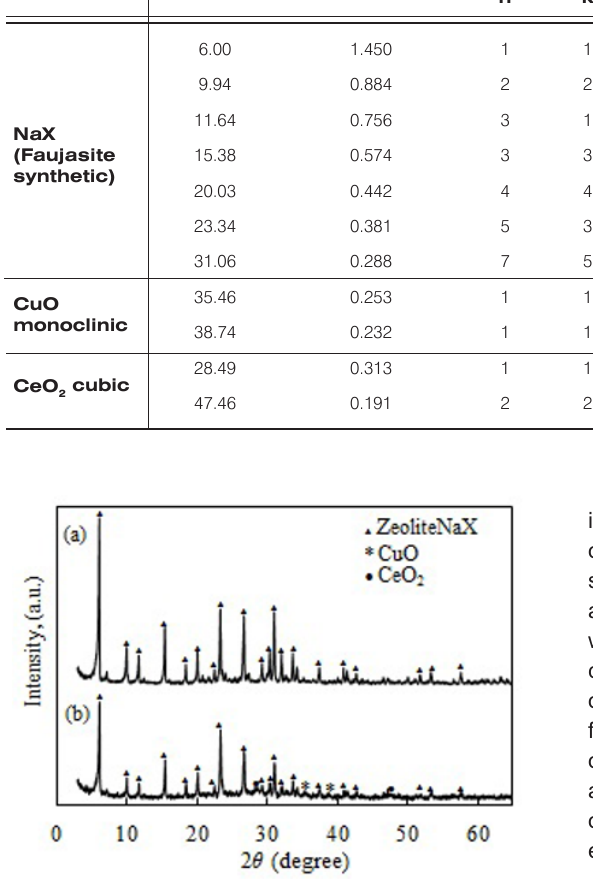
Figure 1. XRD patterns of zeolite NaX (a) and adsorbent-catalyst CuO-CeO /NaX. 2